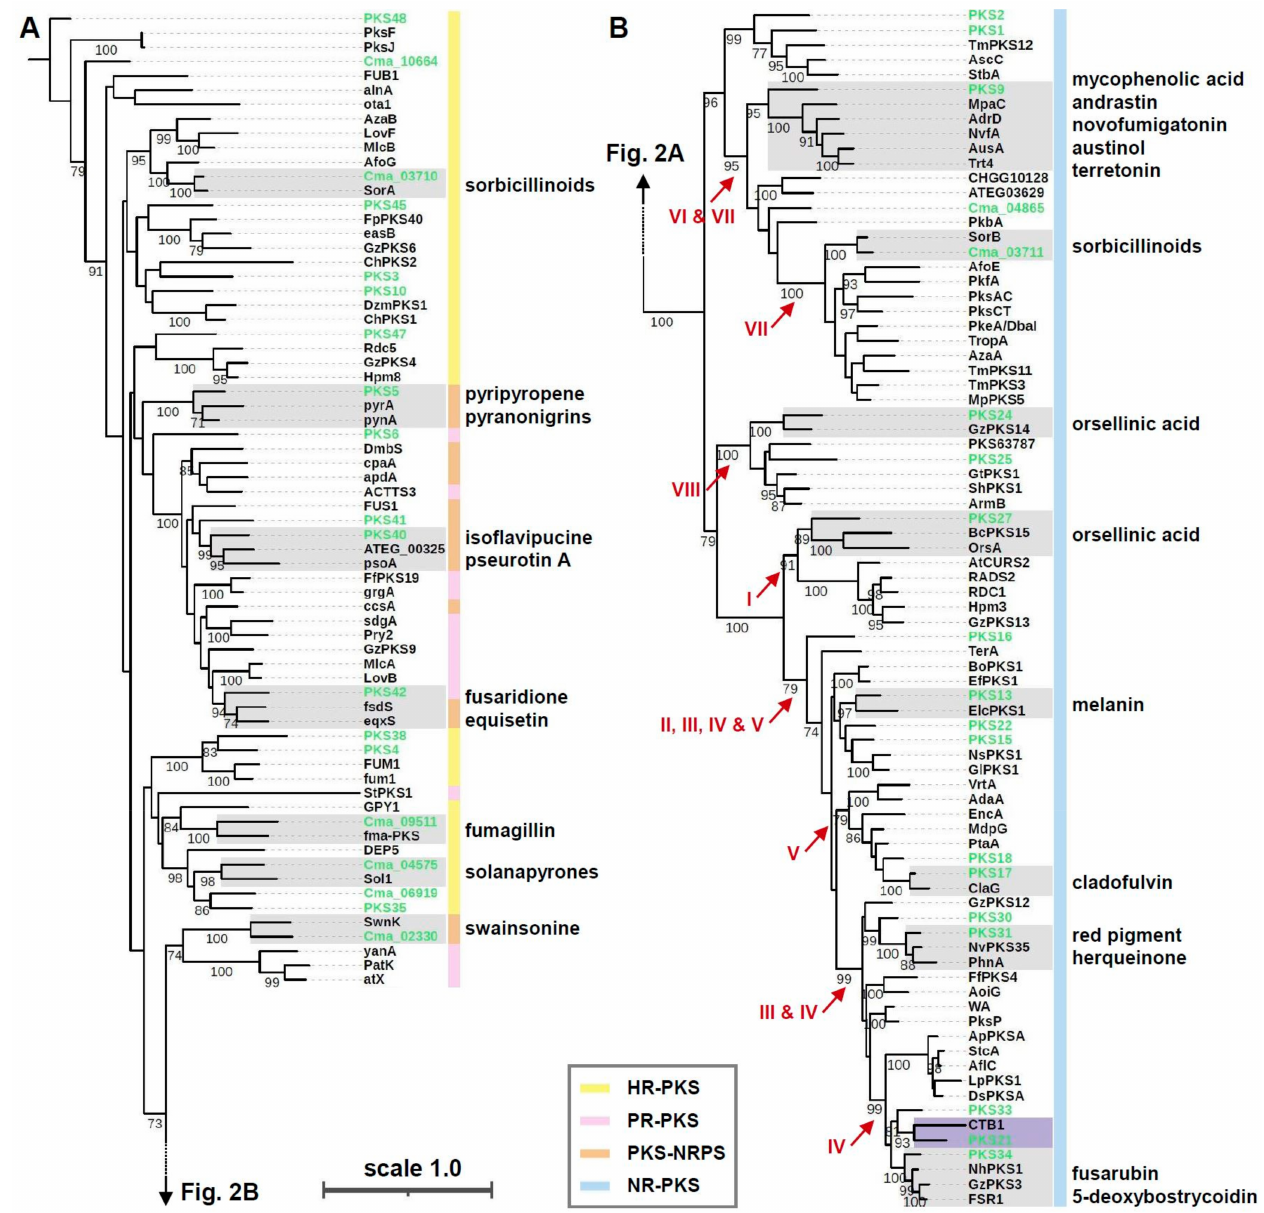
Figure 2. Genealogy of fungal PKS. ( A ) Phylogeny of reducing type (R)-PKS, including highly reducing (HR)-PKS, partially reducing (PR)-PKS, and PKS-non-ribosomal peptide synthetase (NRPS) hybrid enzyme. ( B ) Phylogeny of non-reducing type (NR)-PKS. Roman numerals in red indicate eight phylogenetic groups of fungal NR-PKS. Shaded boxes indicate phylogenetic clades (bootstrap values greater than 90) including a C. macilenta PKS and one or more PKSs characterized in other filamentous fungi. End products biosynthesized by PKSs in other filamentous fungi are denoted in the phylogenetic clades (see Supplementary Table S1). The numbers at the internal nodes indicate bootstrap values greater than 70 from 1000 bootstrap replications. Branch lengths are proportional to the inferred amount of evolutionary change, and the scale represents 1.0 amino acid sequence substitutions per